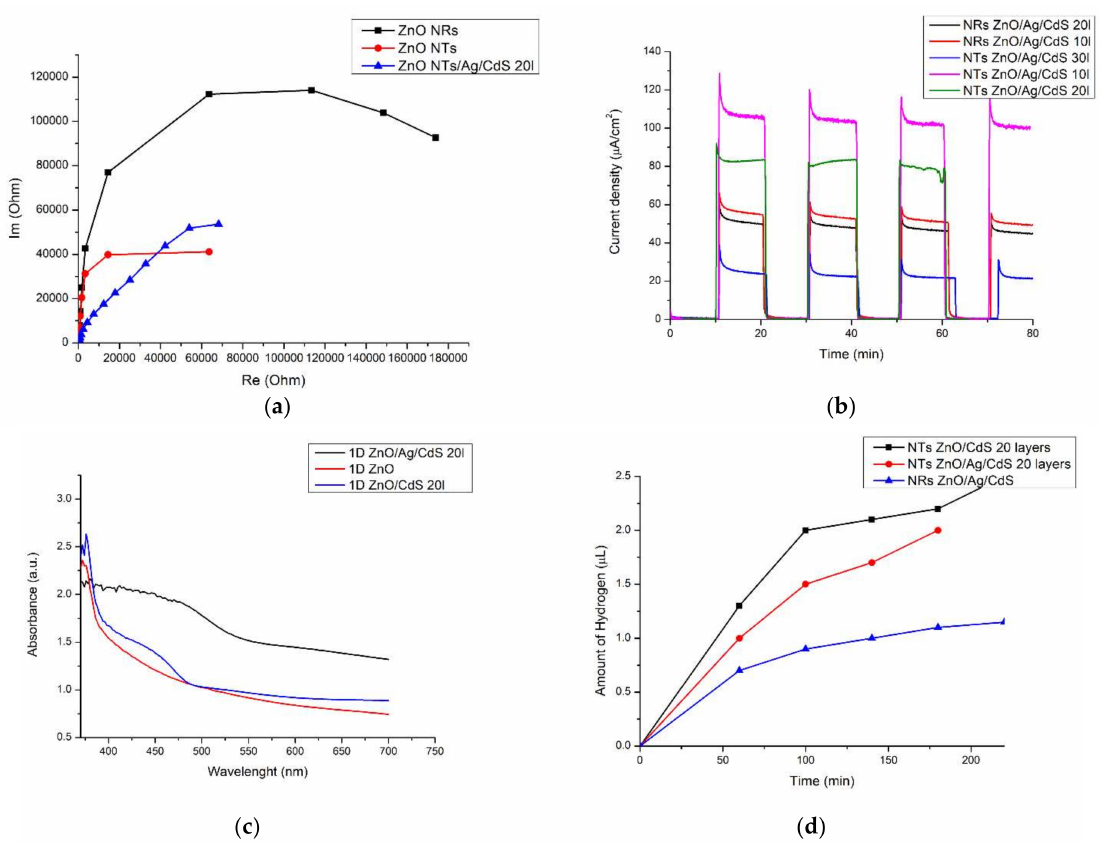
Figure 5. Spectroscopic measurements of structures obtained: ( a ) impedance spectrum of the photoanodes (ZnO NRs, ZnO NTs and ZnO/Ag/CdS nanocomposite—black, red and blue curves, respectively); ( b ) JT diagram of photocurrent in nanocomposites; ( c ) optical absorption spectrum; ( d ) photocatalytic evolution of hydrogen during the decomposition of water in the PEC